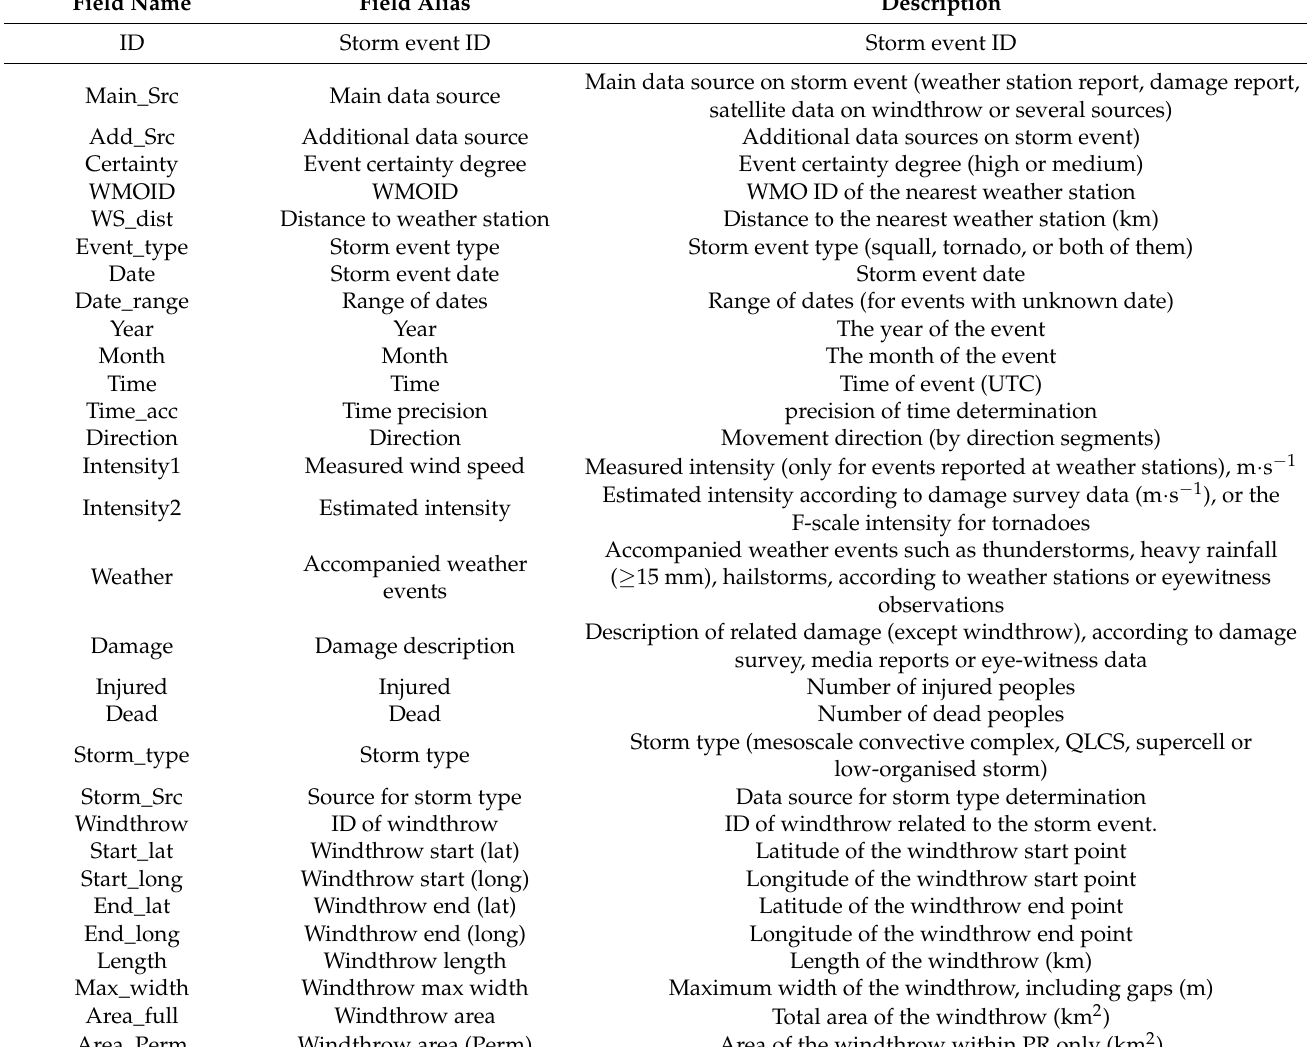
Table 2. Attribute table of the GIS layer of storm